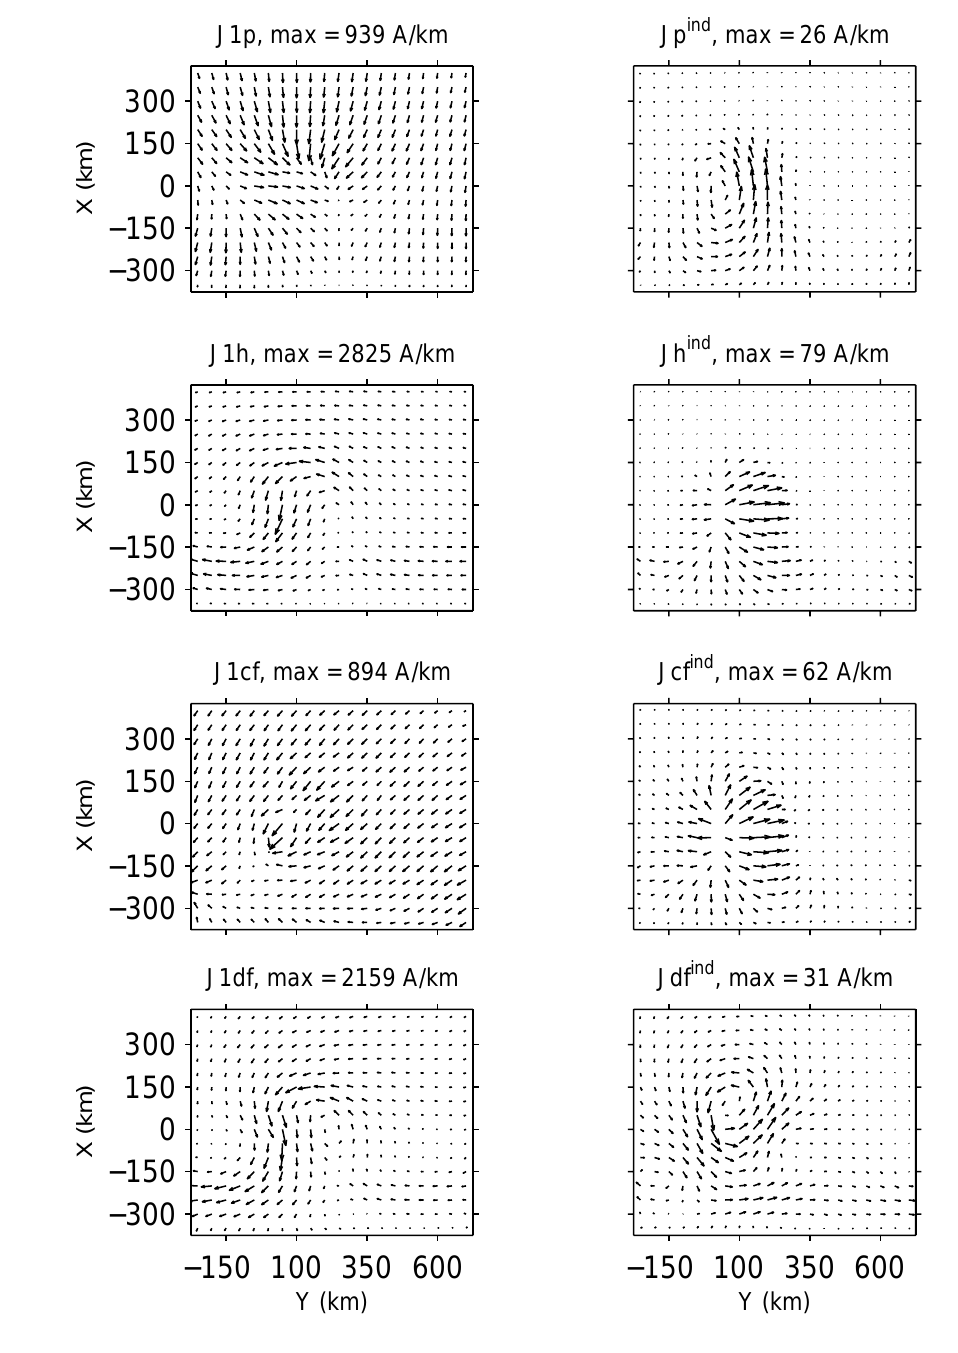
Fig. 14. Same as Fig. 6, but for the (cid:127) -band model.